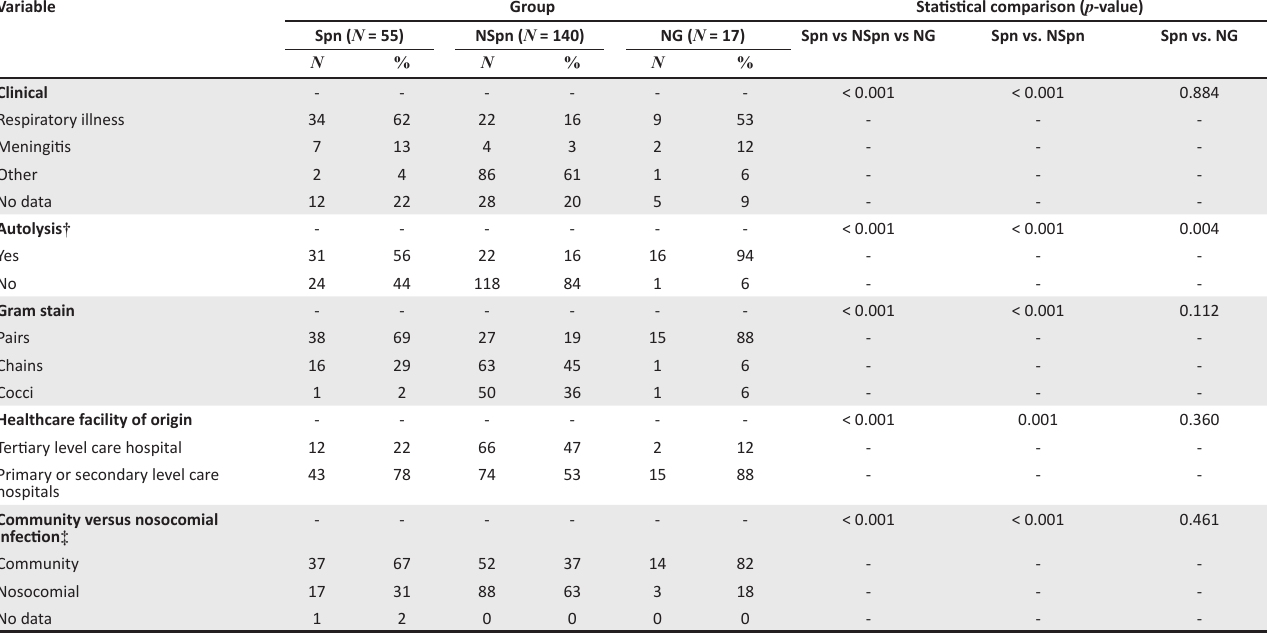
TABLE 2-A1: Clinical, laboratory and epidemiological characteristics of samples grouped according to